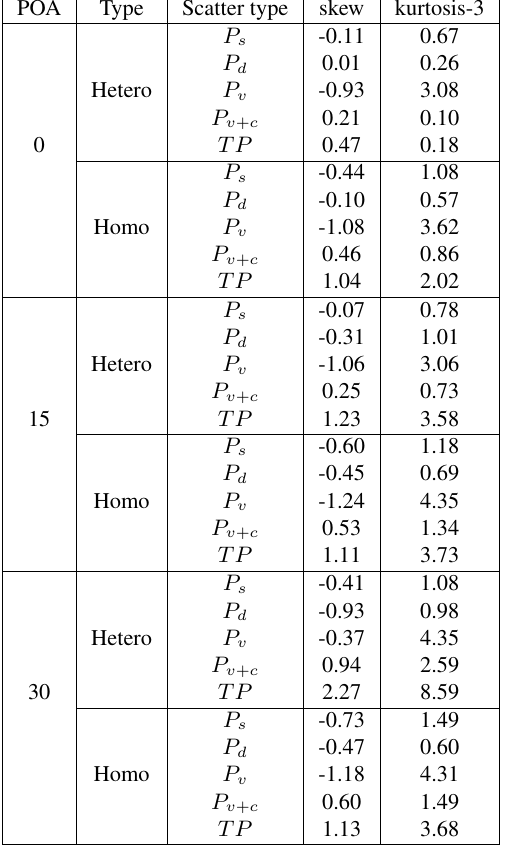
Table 3. Skew and kurtosis of probability density